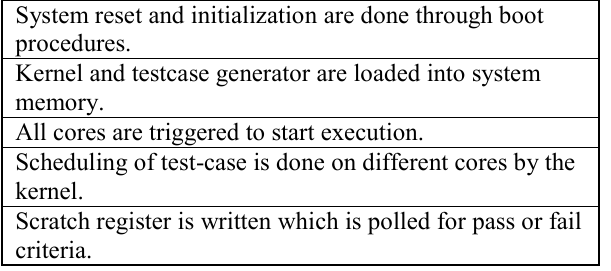
Figure 5. Post Silicon Validation procedure